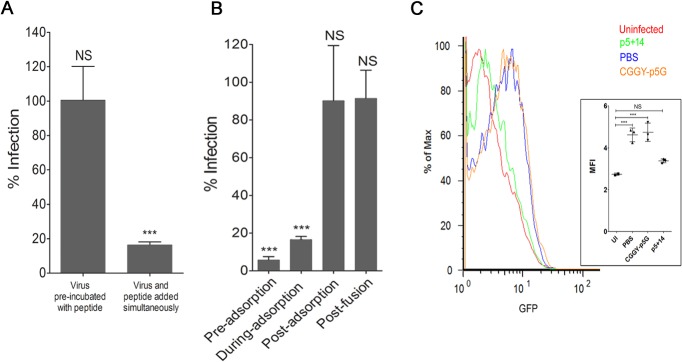
Peptide p5+14 blocks adsorption of MCMV.(A) MCMV was preincubated with p5+14 peptide (100 μM) before diluting the virus/peptide to an ineffective peptide concentration (1 μM) and assayed in the plaque reduction assay as described in materials and methods. As a control, virus and peptide (100 μM) were added to cells simultaneously. (B) Cells were incubated with p5+14 peptide either prior to virus adsorption, during virus adsorption, after virus adsorption (at 4°C) but prior to fusion, or after fusion (at 37°C). Plaque reduction was measured in a plaque reduction assay. Bars represent the average of the percent reduction in infection compared to PBS-treated controls from three independent experiments with at least three replicates in each + SD. Statistical significance is indicated as: * = p<0.05, ** = p<0.01, *** = p<0.001, NS = non-significant difference in the reduction of infection compared to PBS treated control wells. (C) Adsorption of HCMV TB40/E-pp150-GFP (MOI 10) fusion protein expressing HCMV was measured via flowcytometry in the presence of p5+14 (green), control peptide CGGY-p5G (orange) and PBS (blue). Red line represents uninfected cells. Inset is a scatter plot of the mean fluorescence intensity (MFI) for GFP with the line representing average of 3 replicates +/- SD for the different treatments.